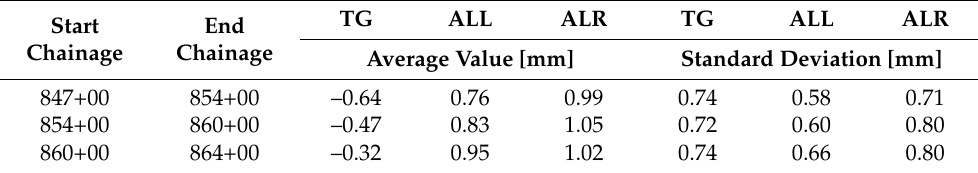
Table 2. Average and deviation of track parameters (section No. 1).